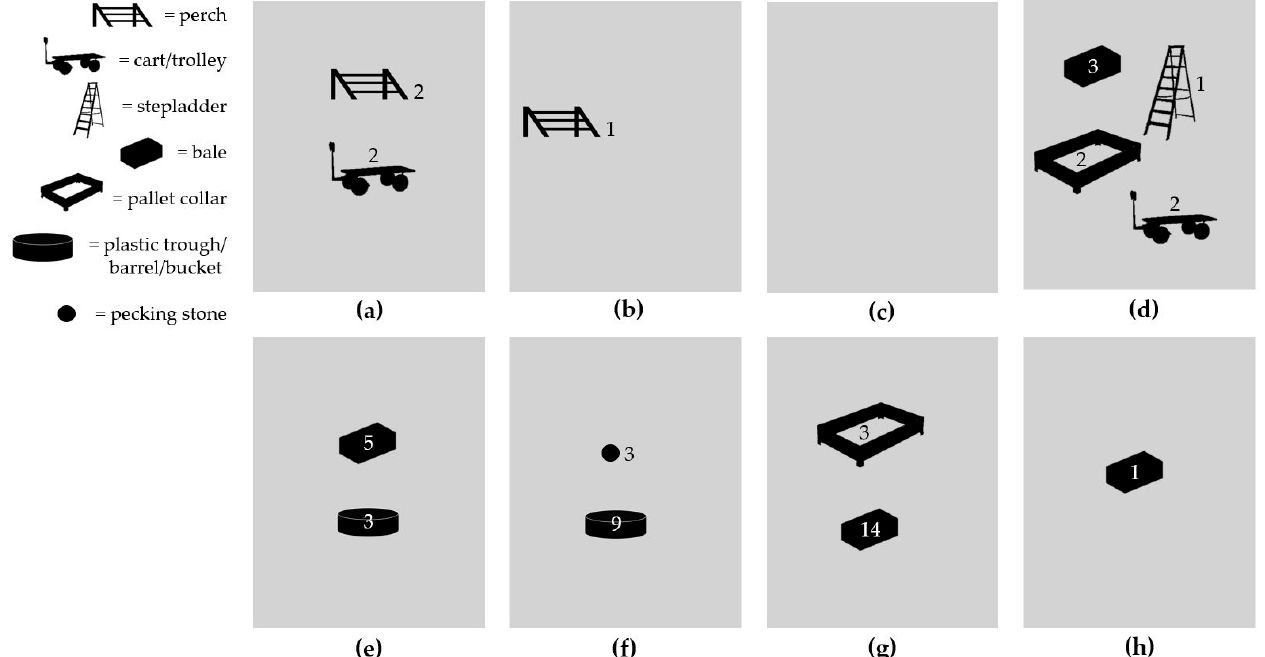
Figure 3. Schematic illustrations (note: not to scale) of environmental enrichment items observed on organic broiler farms ( n = 8) in Sweden: ( a ) perches and trolleys; ( b ) perch; ( c ) no environmental enrichment; ( d ) Lucerne bales, pallet collars, stepladder and carts; ( e ) peat bales and plastic troughs with dust bathing substrate; ( f ) one plastic trough with dust bathing substrate and eight plastic troughs upside down; ( g ) straw bales and pallet collars with dust bathing substrate; ( h ) one large round straw bale.